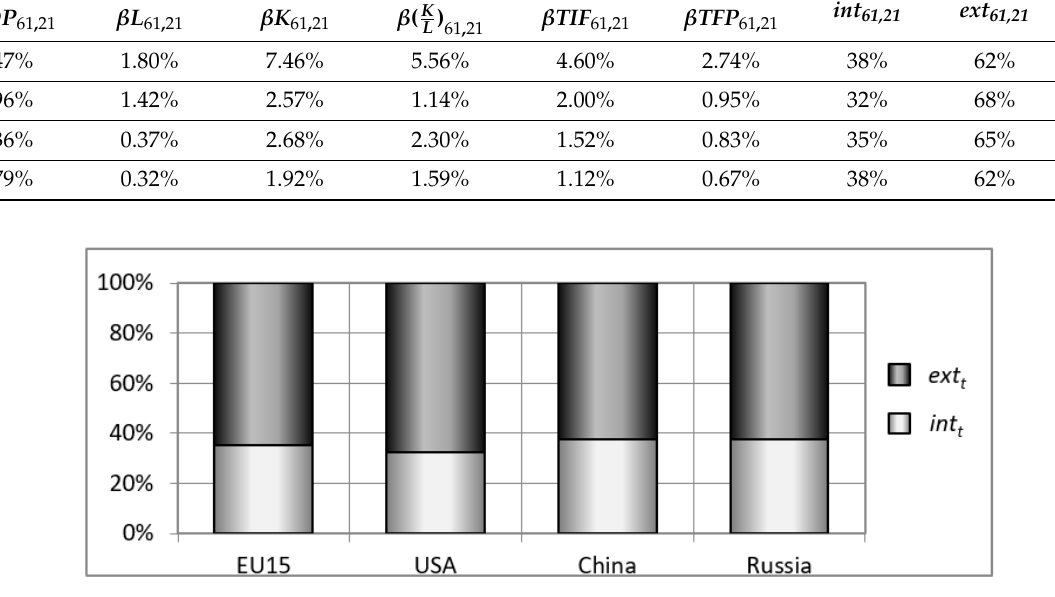
Figure 6. Averrage values of dynamic intensity and extensity indicators for the period 1961 – 2021. Table 3. Relative changes and the indicators int t and int t for the period from 2011 to 2021.